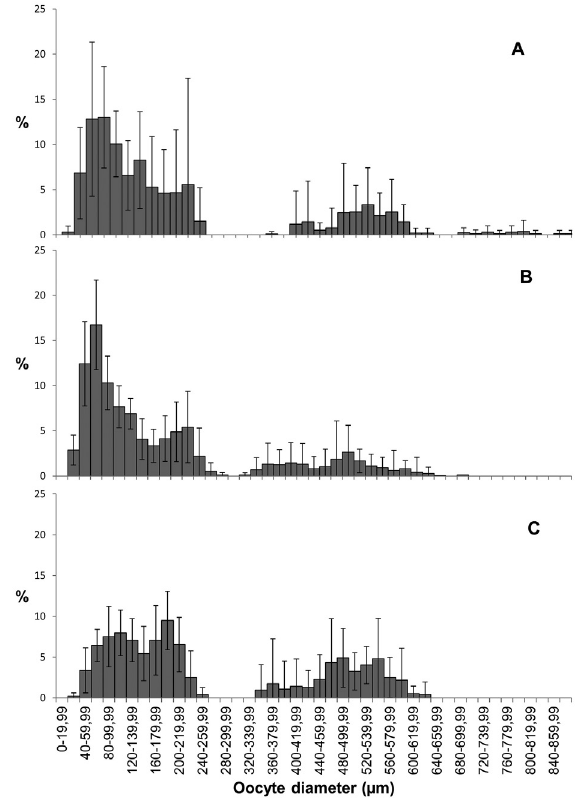
Fig. 6. – Mean size-frequency distribution of oocyte diameters, grouped per 20 µm, from histological sections in females of Aphia minuta (A), P. ferreri (B) and C. linearis (C) sampled in February before the spawning peak. Bars indicate standard